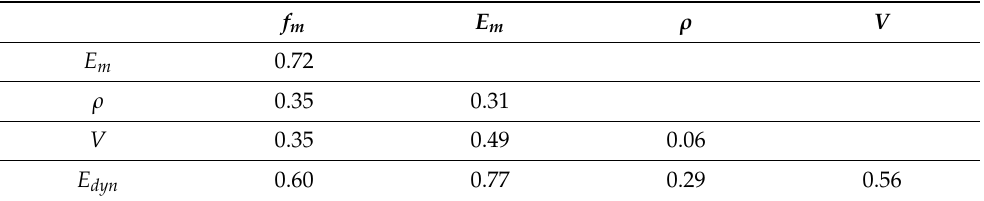
Table 2. Coefficients of determination between properties ( f m = bending strength; E m = static modulus of elasticity; ρ = density; V = velocity; E dyn = dynamic modulus of